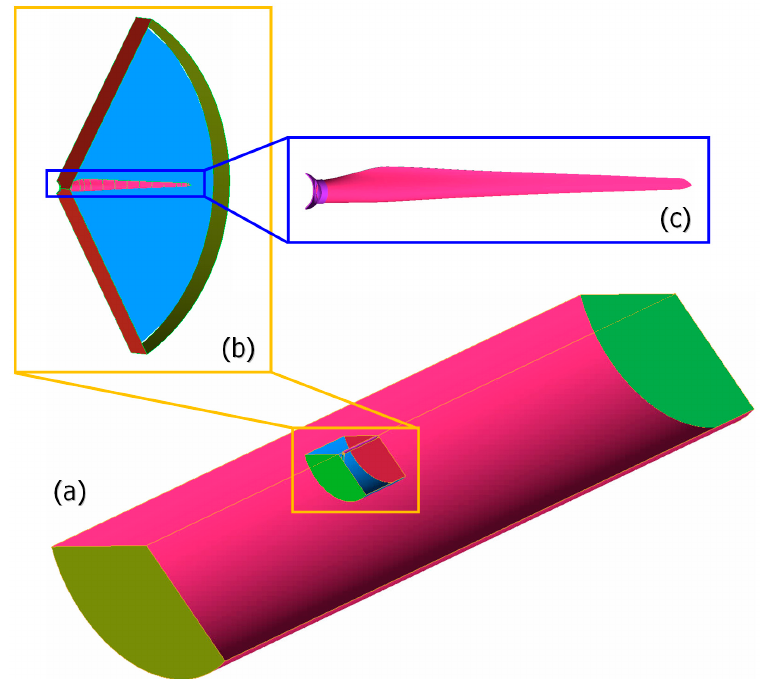
Figure 7. Computational grid for 1/88 scale wind turbine model (1/3 is cut out, but this was actually simulated at 360 deg). ( a ) Total model; ( b ) rotating part; ( c ) wind turbine blade. Energies 2019 , 12 , x FOR PEER REVIEW